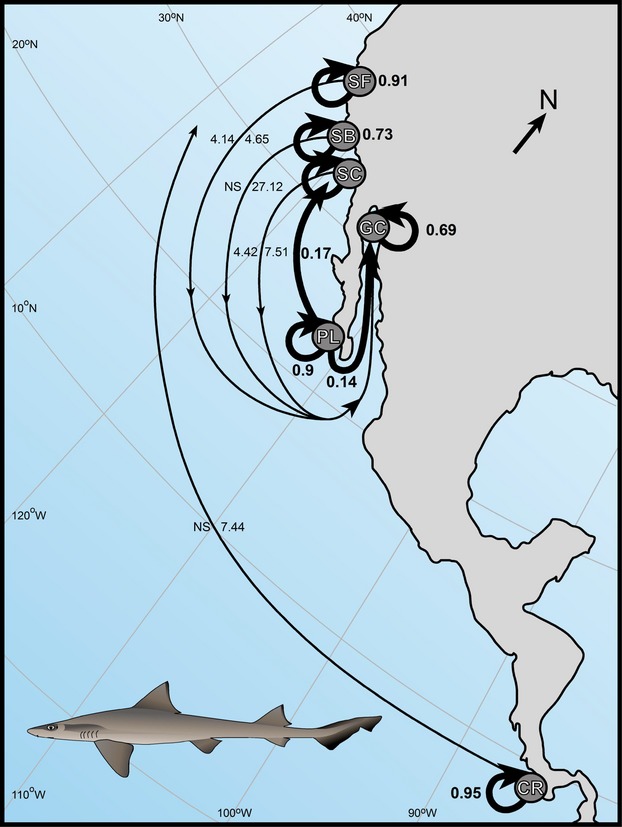
Long-term and contemporary patterns of gene flow (Nem) for Mustelus henlei. Localities are labeled as follows: San Francisco (SF), Santa Barbara (SB), Santa Catalina (SC), Punta Lobos (PB), San Felipe (GC), and Costa Rica (CR). Thin lines depict the results of MIGRATE-N analyses and the general direction of gene flow as averaged across localities from the point of origin. Estimates of Nem with credible sets (CS) not overlapping 0 are provided on either side of lines (mtCR to the left and microsatellites to the right). Bold lines depict the direction of gene flow as estimated by BAYESASS with Nem values with CS's not including 0 provided.